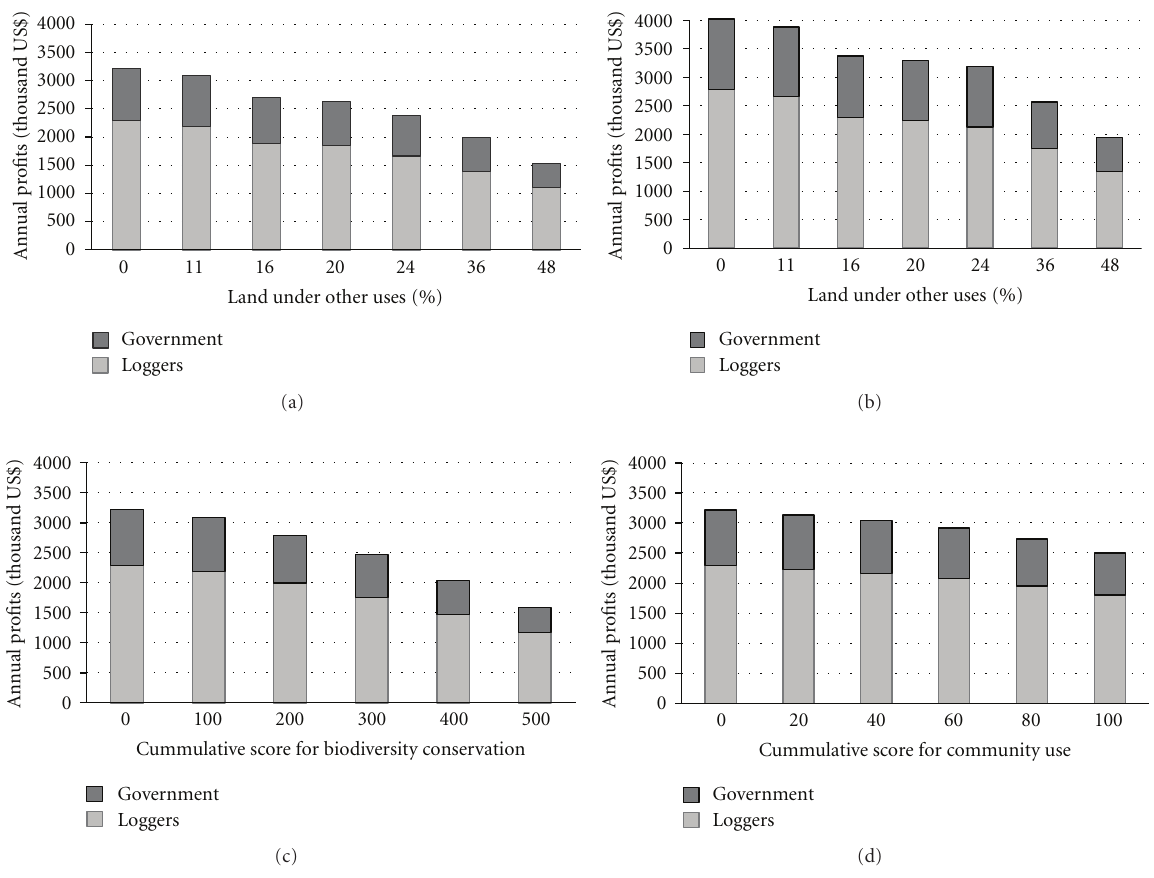
Figure 4: Annual profits from logging in Faro State Forest for government and loggers with an increasing number of stands in nonlogging land uses harvested by current logging centers (a) or from closer cities (b); annual profits from logging in Faro State Forest for government and loggers with an increasing cumulative score for biodiversity conservation (c) and for community use